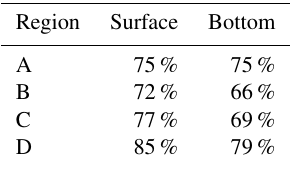
∗ Percent calculated as the expected change in bottom DO, as predicted by solubility, divided by the modeled change in bottom